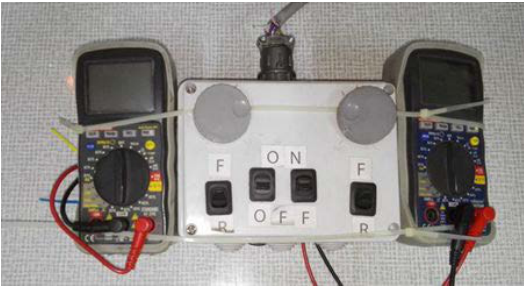
Fig. 8. Connected voltmeters for speed verification